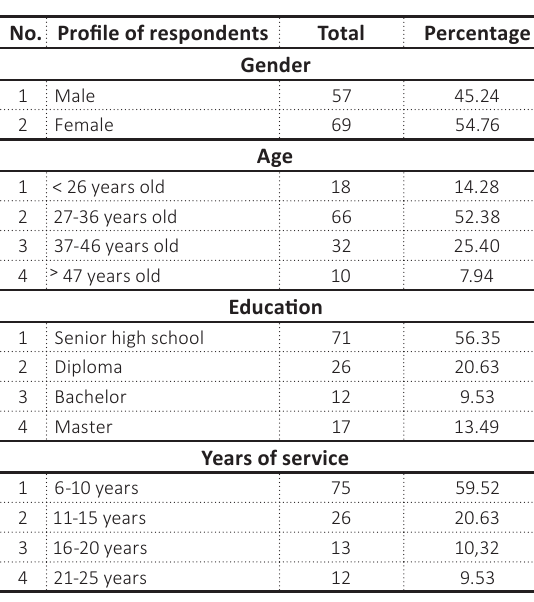
Table 1. Profile of the